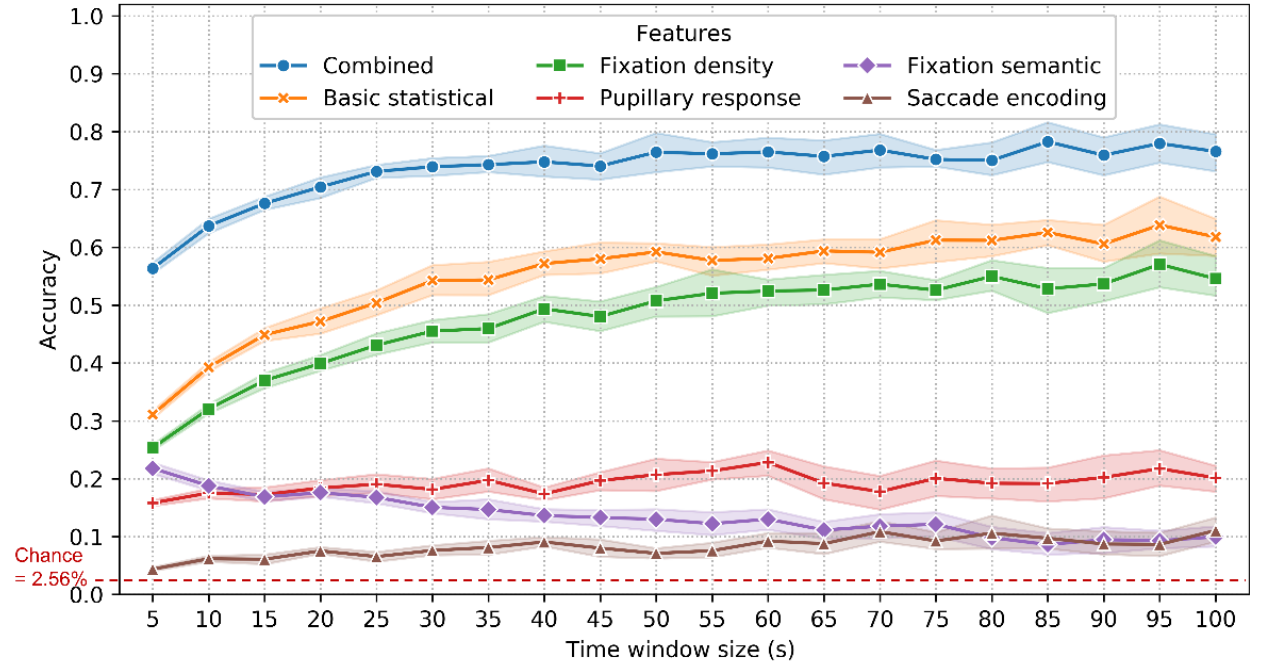
Figure 7. Accuracy and 95% confidence interval (CI) with varying time window size and feature types using the 10-fold classification. Refer to Table A1 in Appendix A for detailed accuracy values.